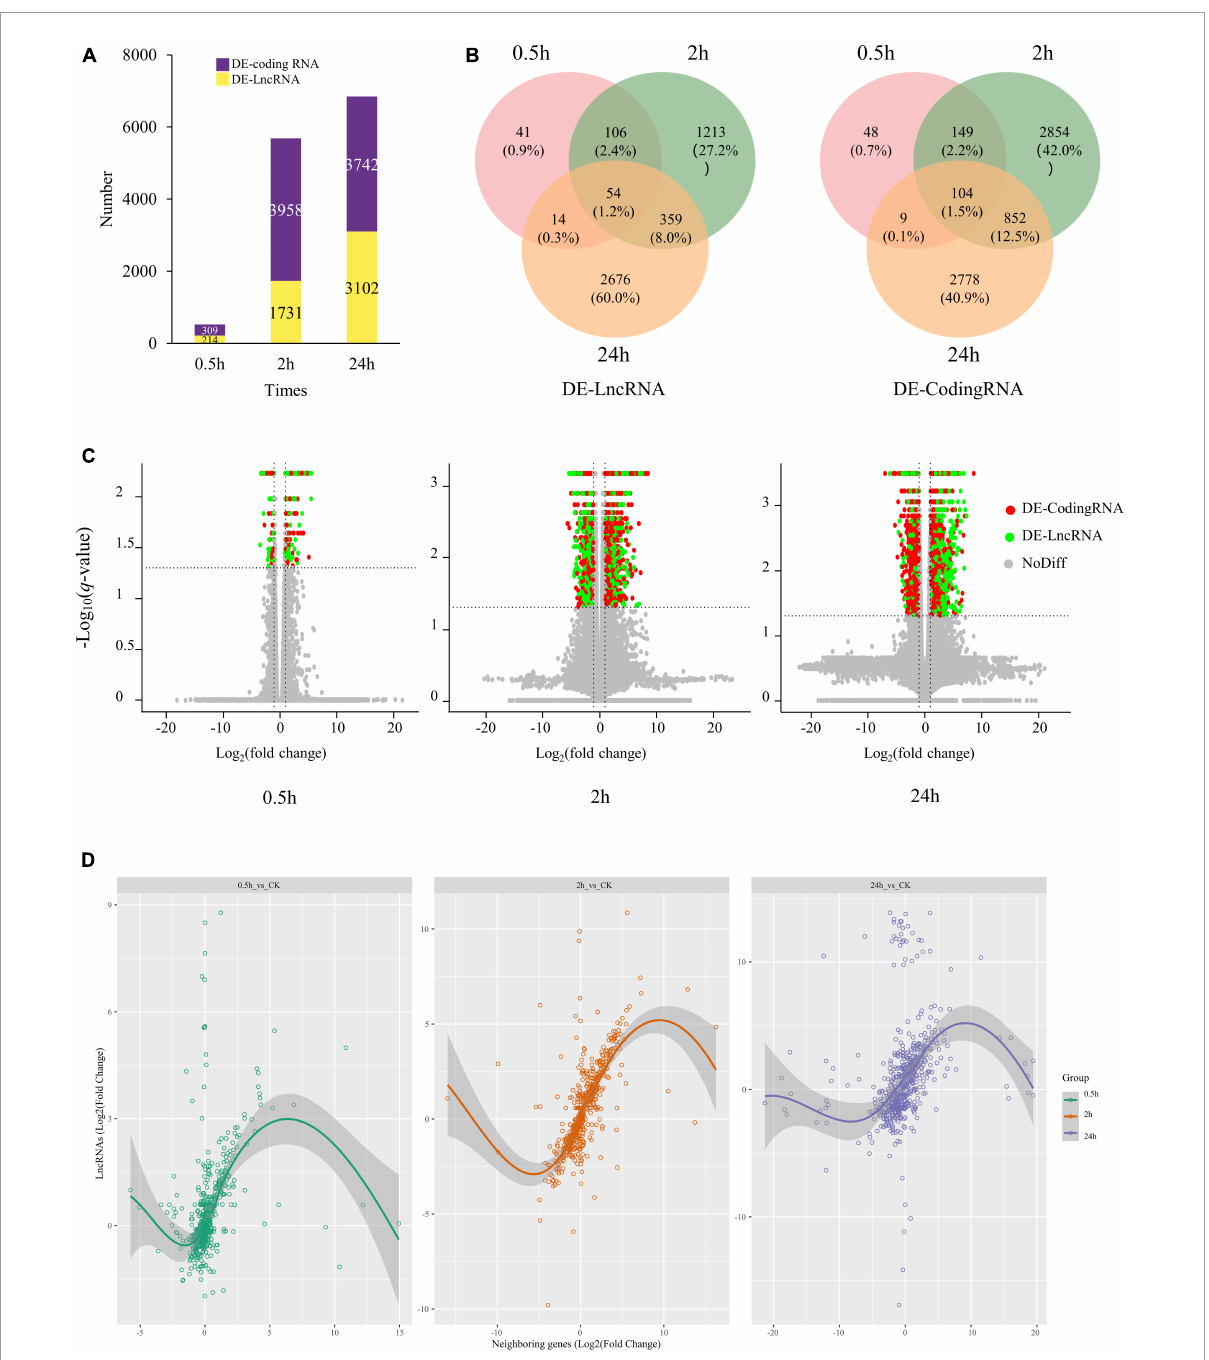
FIGURE2 The expression profile of coding RNAs and LncRNAs under salt stress in quinoa roots. (A) Number of DE-coding RNAs and DE-LncRNAs identified at 0.5, 2, and 24 h of salt treatment. (B) Venn diagrams of DE-coding RNAs and DE-LncRNAs. (C) Volcano plots of DE transcripts at 0.5, 2, and 24 h of salt treatment. Red point represented DE-coding RNAs; green point represented DE-LncRNAs; gray point represented non-DE transcripts. (D) Correlation plot of salt-responsive LncRNAs and their closest neighboring genes at 0.5, 2, and 24 h under salt stress.